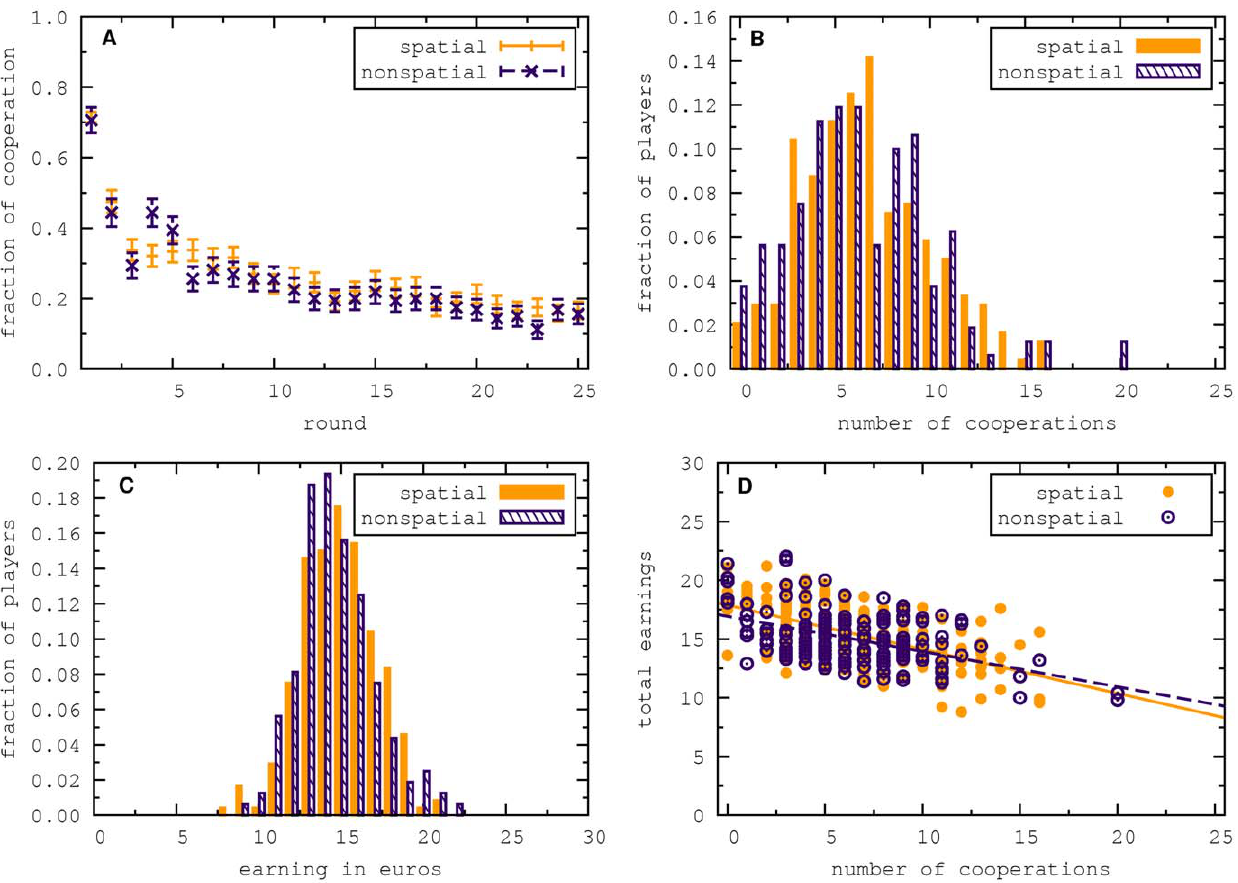
Figure 1. Comparison of the spatial and non-spatial treatments. (a) The fraction of players that have chosen to cooperate is decreasing over time, but remains substantial throughout the experiment [35]. The error bars are the standard deviations of a binomial distribution, , where n is the number of samples and C is the fraction of cooperation. (b) The distribution of cooperative acts per player. We do not observe unconditional cooperation, and very little unconditional defection (5 out of 240 players in the spatial treatment and 6 out of 160 players in the non spatial treatment). (c) The distributions of cumulative payoffs are peaked with median of 15.4 J for the spatial and 15.0 J for the non spatial treatment. The standard deviation is 2.3 J in both cases. (d) Correlation between the frequency of cooperation on the x-axis and the cumulative payoff on the y-axis. Each point is one player.